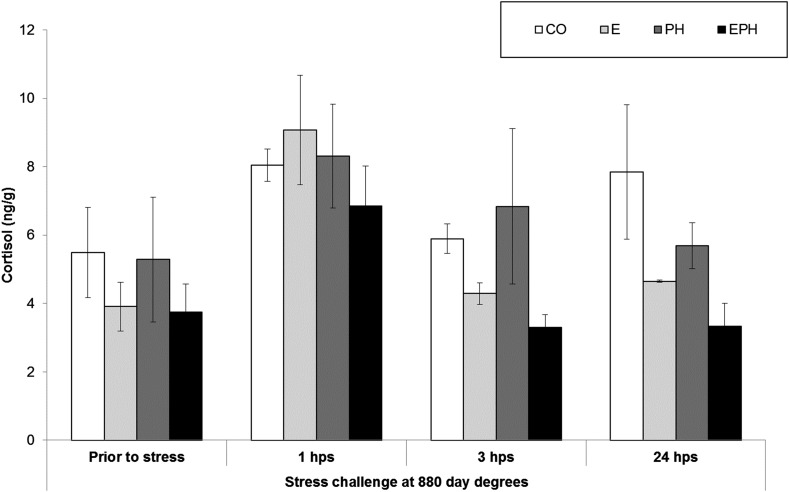
Cortisol concentrations measured in CO, E, PH and EPH treated fish prior to stress and at 1, 3 and 24 hr post-stress (hps).